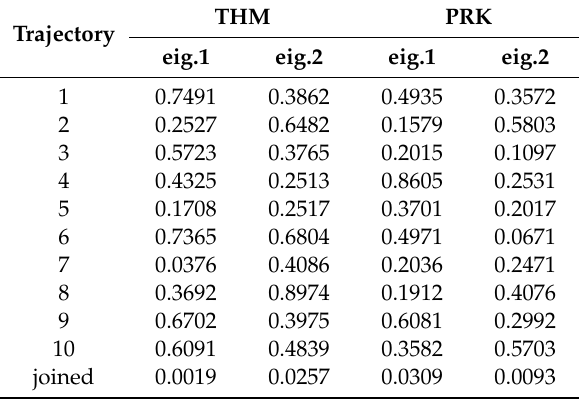
Figure 2. Evolutions of the backbone RMSD values of the THM and PRK with respect to their starting structures during the 10 independent MD simulations (Replicas 1–10). ( A ) THM; ( B ) PRK. Table 1. Cosine content values of the first two eigenvectors calculated from the ten independent equilibrium MD trajectories (30–100 ns; Replicas 1–10) and the single 700-ns joined